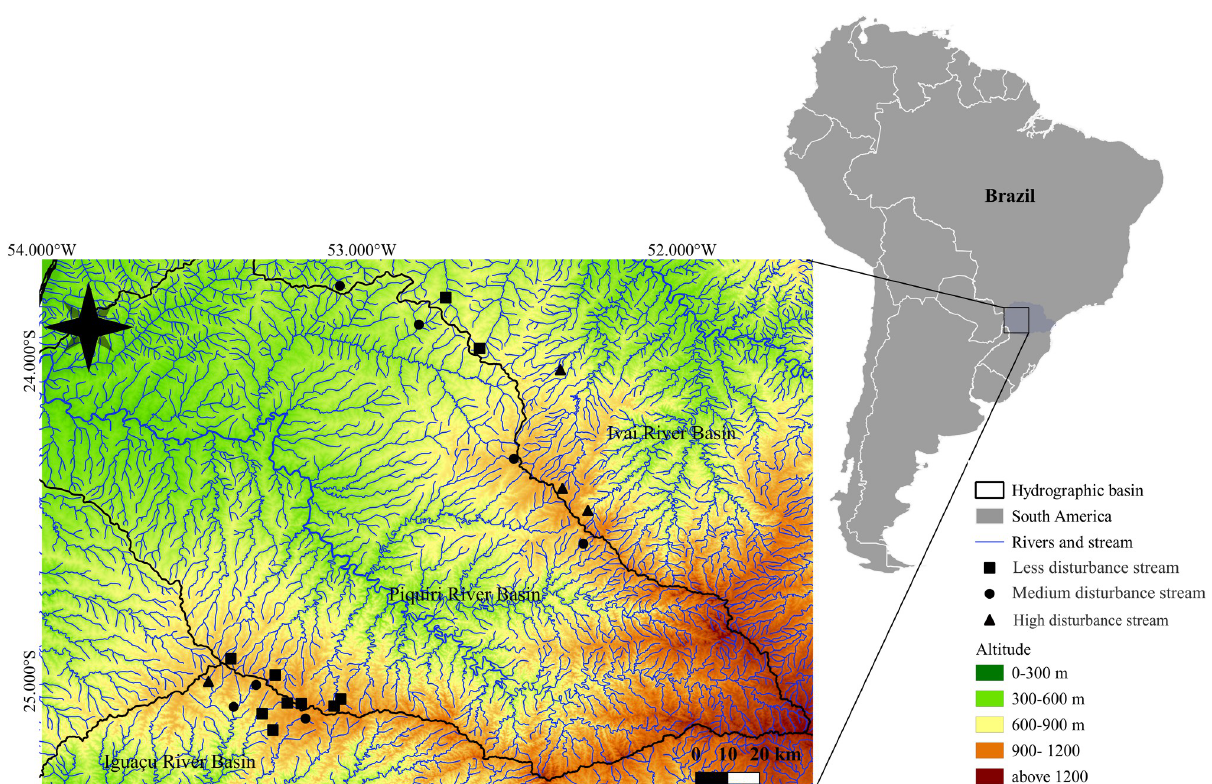
Fig 1. Study area: Sampling sites distributed in the Iguac¸u, Piquiri, and Ivaı´River Basins, Brazil. The classification of streams as high, medium and low disturbance was according to the Integrated disturbance index values: < 0.09 values—low disturbance (sites with conditions closer to the natural), 0.10 to 0.19—medium disturbance (altered sites), > 0.2—high disturbance (extremely impacted sites). “Raster data obtained from EMBRAPA (Intellectual Property Rights—US Geological Survey), accessed on March 20, 2022. https://www.cnpm.embrapa.br/projetos/relevobr/download/pr/pr.